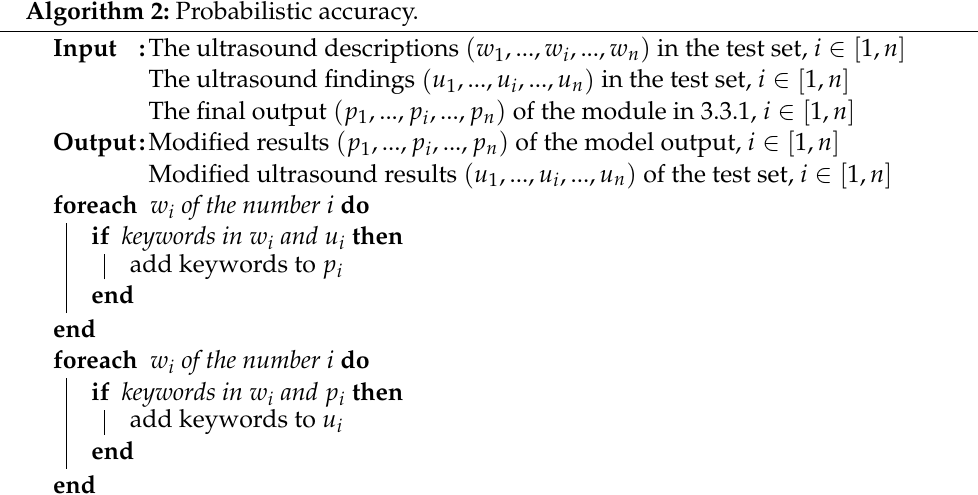
Algorithm 2: Probabilistic